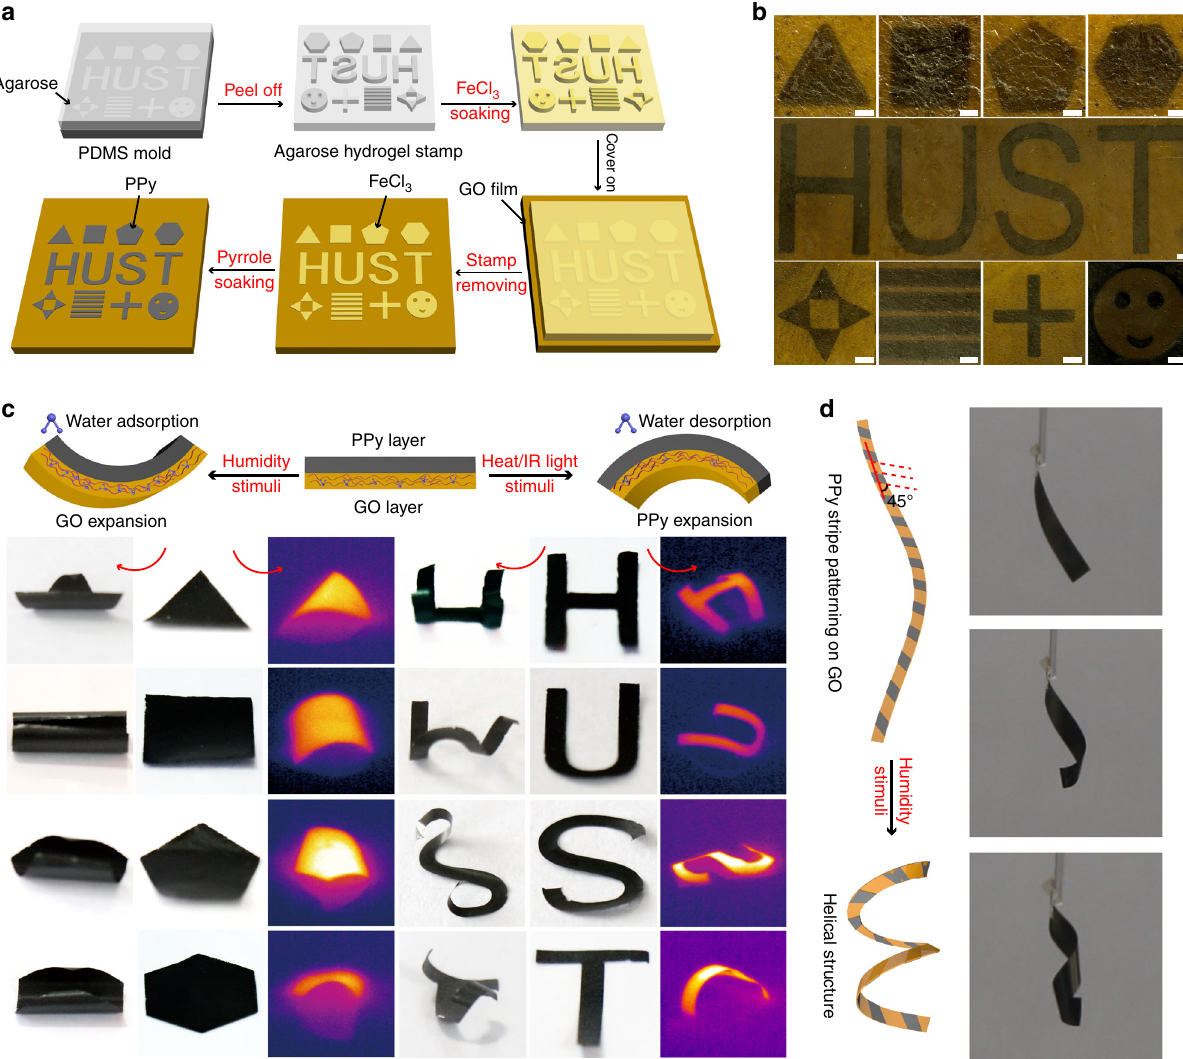
Fig. 1 Fabrication and programmable structure changes of actuator. a Schematic diagram of precise PPy patterning on a GO fi lm for the fabrication of a programmed GO/PPy actuator; b optical image of precise PPy patterning on a GO fi lm (Scale bar: 100 μ m); c working mechanism of GO/PPy bilayer actuator and the structural changes of actuators with regular triangle, square, regular pentagon, regular hexagon, and H-, U-, S-, and T-shape patterns under the stimuli of humidity and IR light; d schematic diagram of a programmable GO/PPy